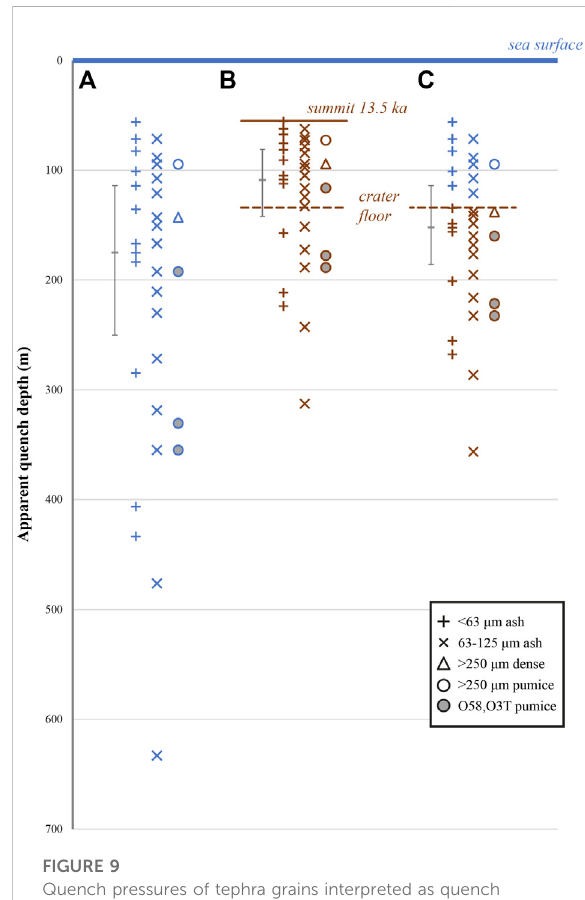
FIGURE 9 Quench pressures of tephra grains interpreted as quench depths below sea surface (Depth = 0 m) for three eruption scenarios. (A) Assuming tephra all quenched in water column overlying a vent of unknown water depth: hydrostatic pressuregradientof1,025 kg/m 3 applies.TephraOHcontentsthus indicate quench in water from 56 – 633 m b.s.l. (B) Assuming tephra quenched in shallow maar-type or phreatomagmatic eruption prior to formation of Oomuro Hole crater: hydrostatic pressure applies to depth of fl at summit (55 m b.s.l. at 13.5 ka); belowthisdepthlitho/magmastatic pressuregradientof2,300 kg/ m 3 applies. Tephra OH contents thus indicate quench within shallow edi fi ce. (C) Assuming tephra quenched in shallow maar- typeorphreatomagmaticeruptionafter80 m-deepOomuroHole crater had formed: hydrostatic pressure applies to bottom of crater (134 m b.s.l. at 13.5 ka); below this depth litho/magmastatic pressure gradient of 2,300 kg/m 3 applies. Tephra OH contents thus indicate quench of majority of grains within shallow edi fi ce withsomegrainsquenchinginwaterwithincrater.Errorbarsshow representative errors calculated for a grain with representative mean OH wt% and 2SE error (OH 0.46 wt%; 2SE 0.08). Grey symbols are pumice data from subaerial layers O58 and O3T reported in McIntosh et al.